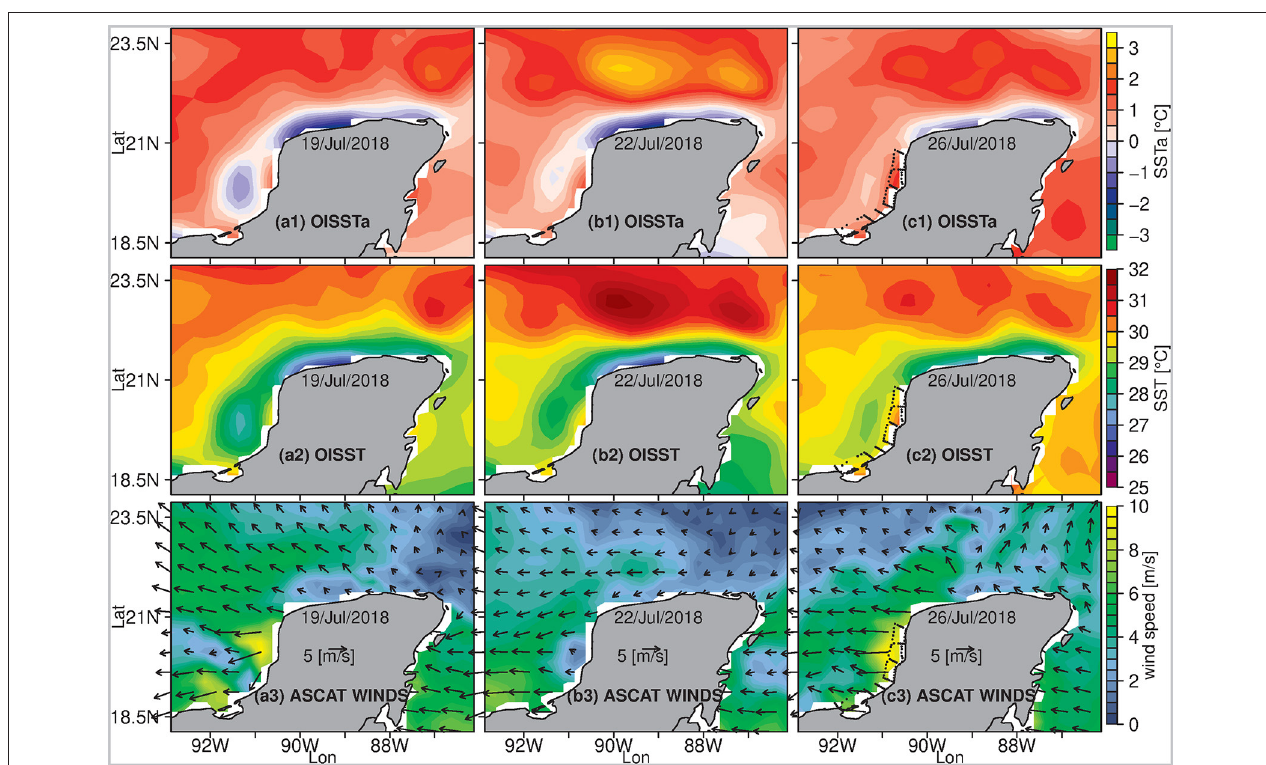
FIGURE 8 | Satellite images of the end of July 2018, of the regional distribution of Sea Surface Temperature anomalies (a1,b1,c1) , SST (a2,b2,c2) , and surface winds (a3,b3,c3) .